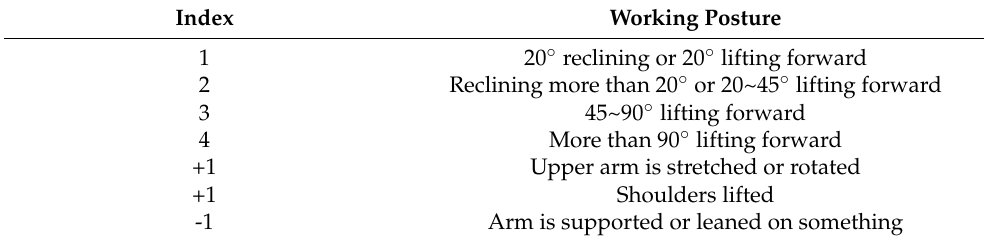
Table 9. Classification based on the upper arm posture.